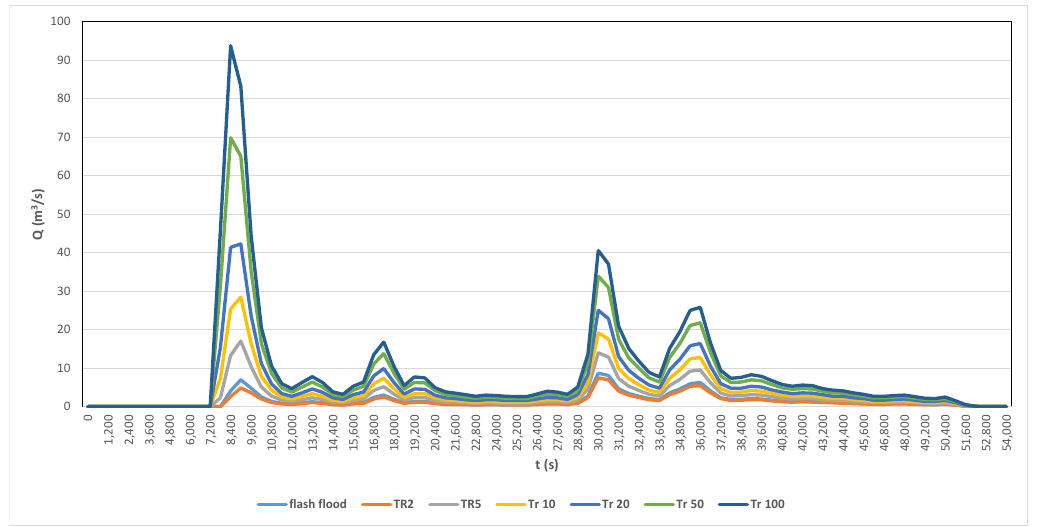
Figure 9. Estimated hydrographs for storms with different Tr and historical flash flood.